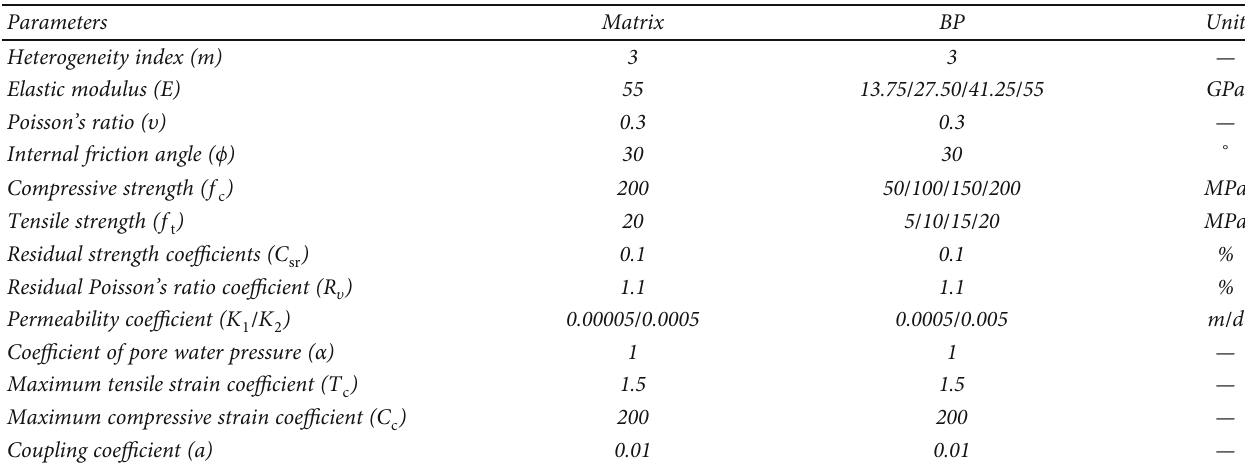
Table 1: Mechanical parameters of the